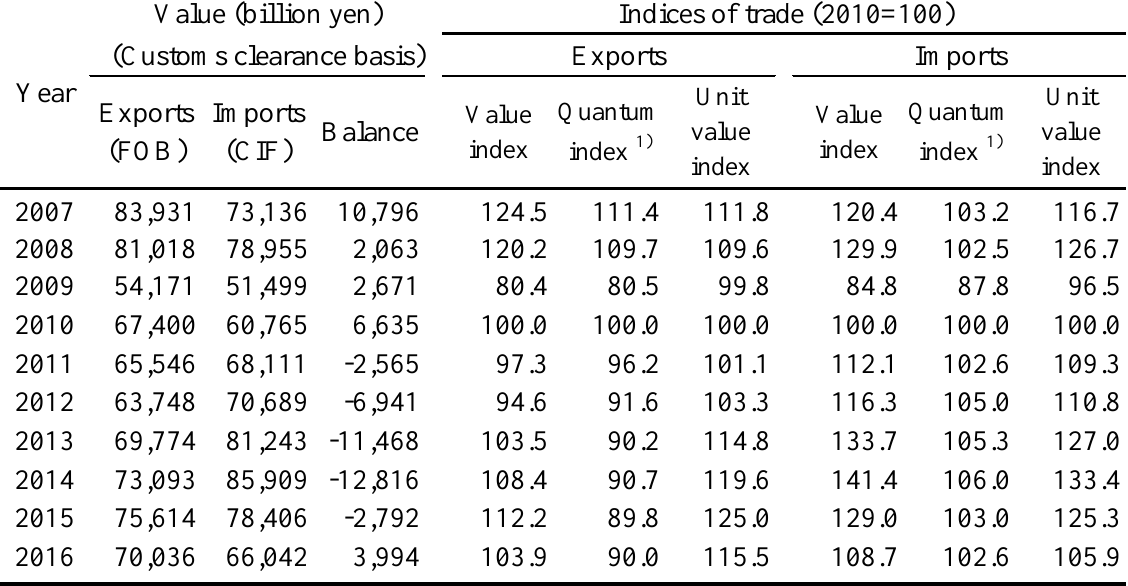
Trends in Foreign Trade and Indices of